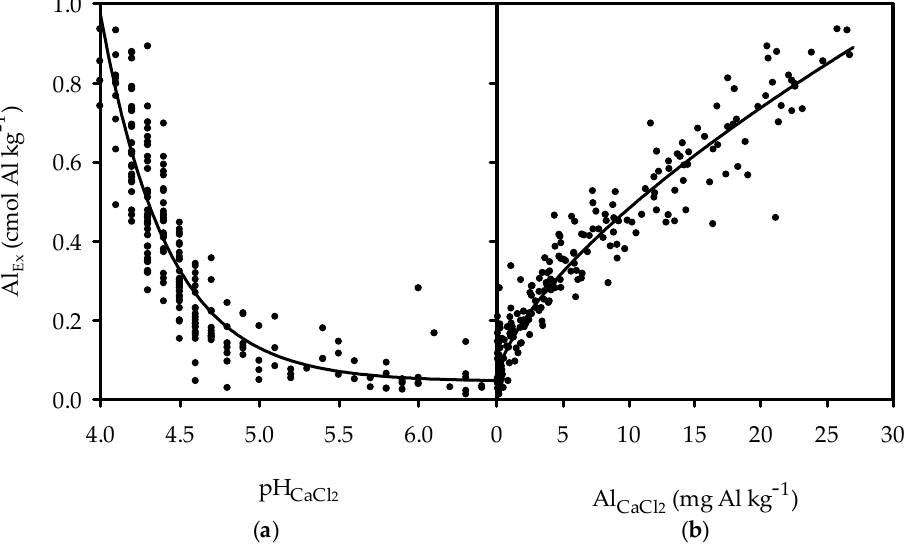
Figure 4. ( a ) Relationship between pH CaCl 2 and Al Ex : Al Ex = 0.04 + (13,648 × exp( − 2.40 × pH CaCl 2 ), r 2 = 0.82; and ( b ) Al CaCl 2 and Al Ex , Al Ex = 0.05 + (0.093 × (Al CaCl 2 0.668 ), r 2 = 0.93.